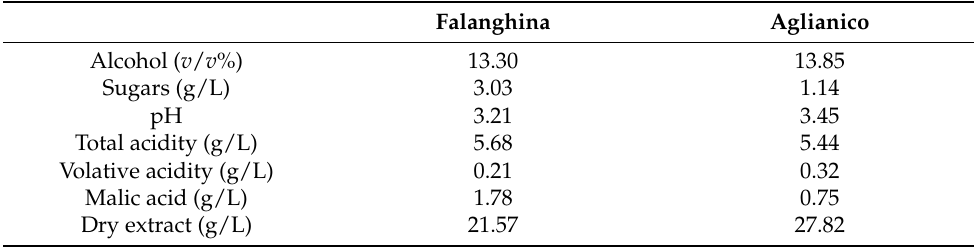
Table 7. Wine chemical